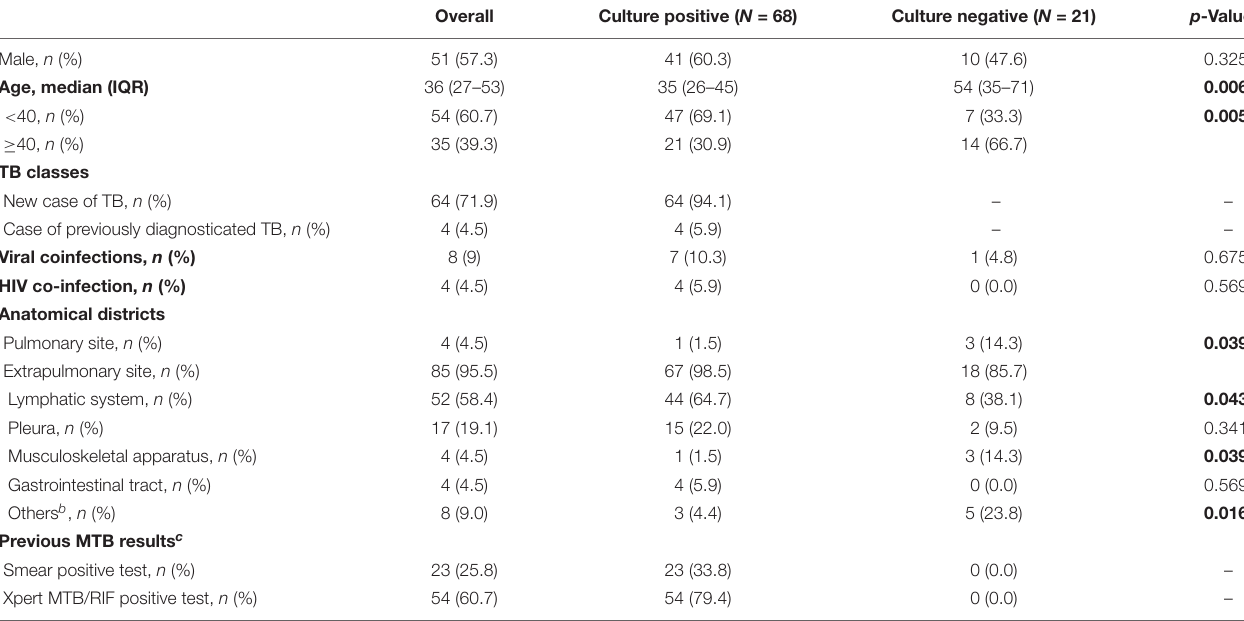
TABLE 1 | Demographic and clinical data of the sampled population. Overall Culture positive ( N = 68) Culture negative ( N =